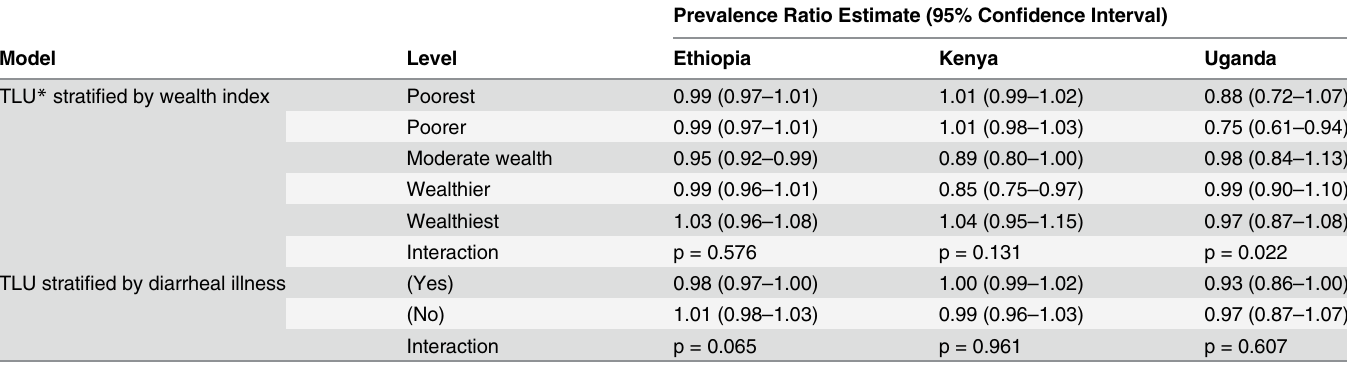
Table 3. Log-binomial models for the relationship between household livestock ownership and stunting prevalence, as stratified by wealth and two-week diarrheal disease history.